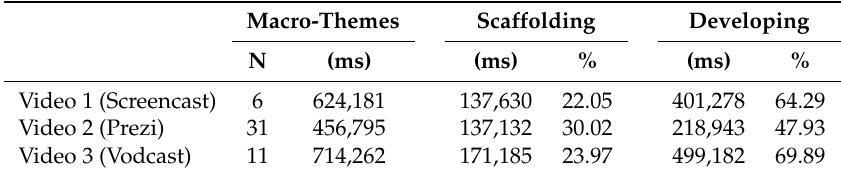
Table 1. Number and durations of visual macro-themes and durations of scaffolding and developing segments in the three videos. Percentages indicate the ratio with the overall macro-theme durations.